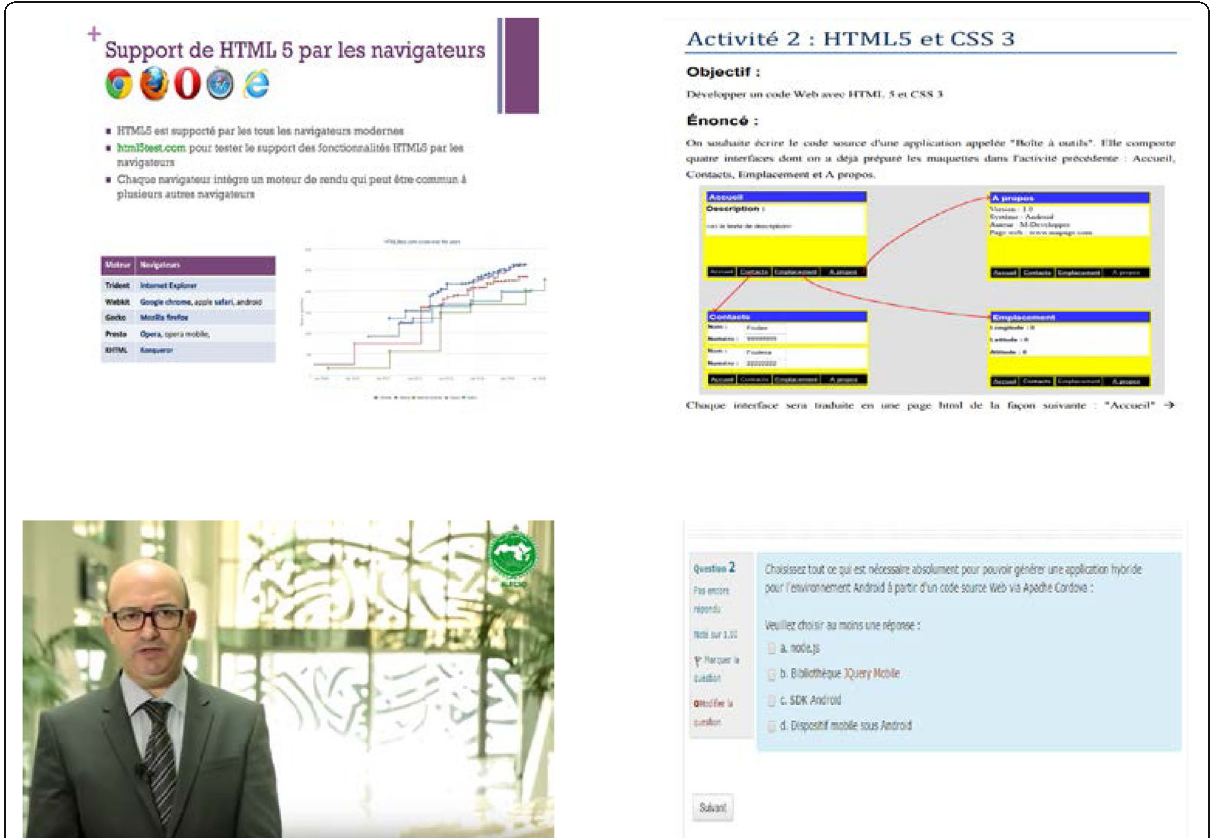
Fig. 10 M-Developer SPOC